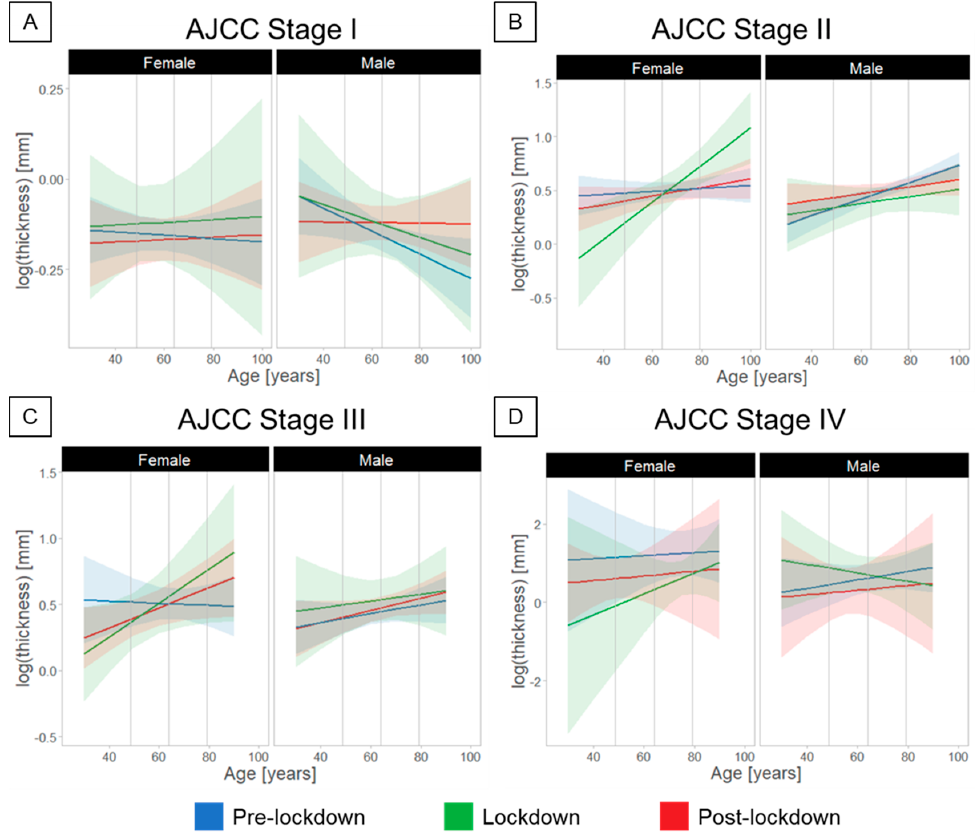
Figure 3. Age- and gender-dependent differences in the diagnosis of melanomas relative to the COVID-19 lockdown in Switzerland, considering stratification of melanomas in AJCC stages. ( A ) Stage I, ( B ) Stage II, ( C ) Stage III, ( D ) Stage IV. Effects of lockdown on the diagnosed melanoma thickness for older female patients were found only for stage II melanoma.